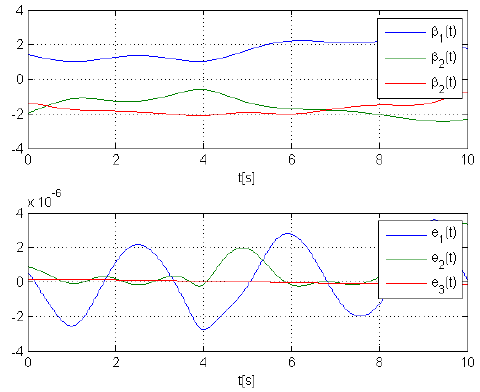
( ) t  ( ) t  and the related error and the related error ( ) t  and the related error